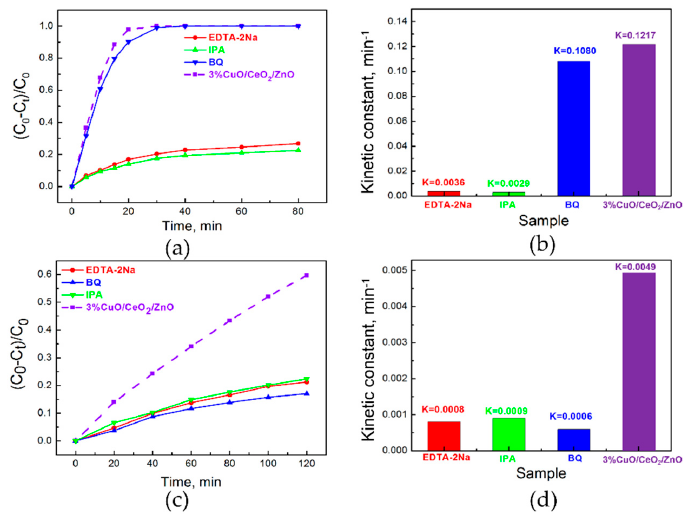
Figure 7. Degradation curves of MB with quenching agents and the corresponding kinetic constants under ( a , b ) UV light and ( c , d ) visible